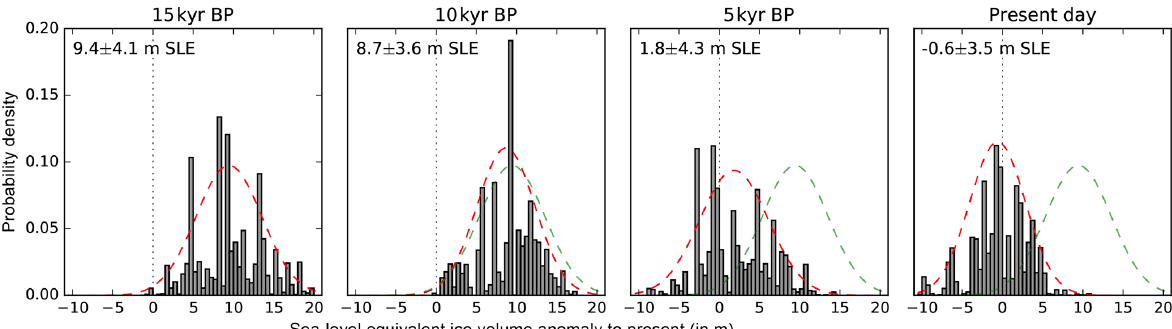
Figure 10. Histogram of ensemble global mean sea-level contributions relative to modern observation at every 5kyr over the last deglaciation period. Grey bars show the score-weighted ensemble distribution (0.5m bins); the red curve indicates the statistically likely range (normal distribution) of the simulated ice volumes with width of 1 σ standard deviation, as for the green envelope in Fig. 9. Green Gaussian curve from 15kyr snapshot for comparison (compare to Figs. 6 and C5 in Pollard et al.,